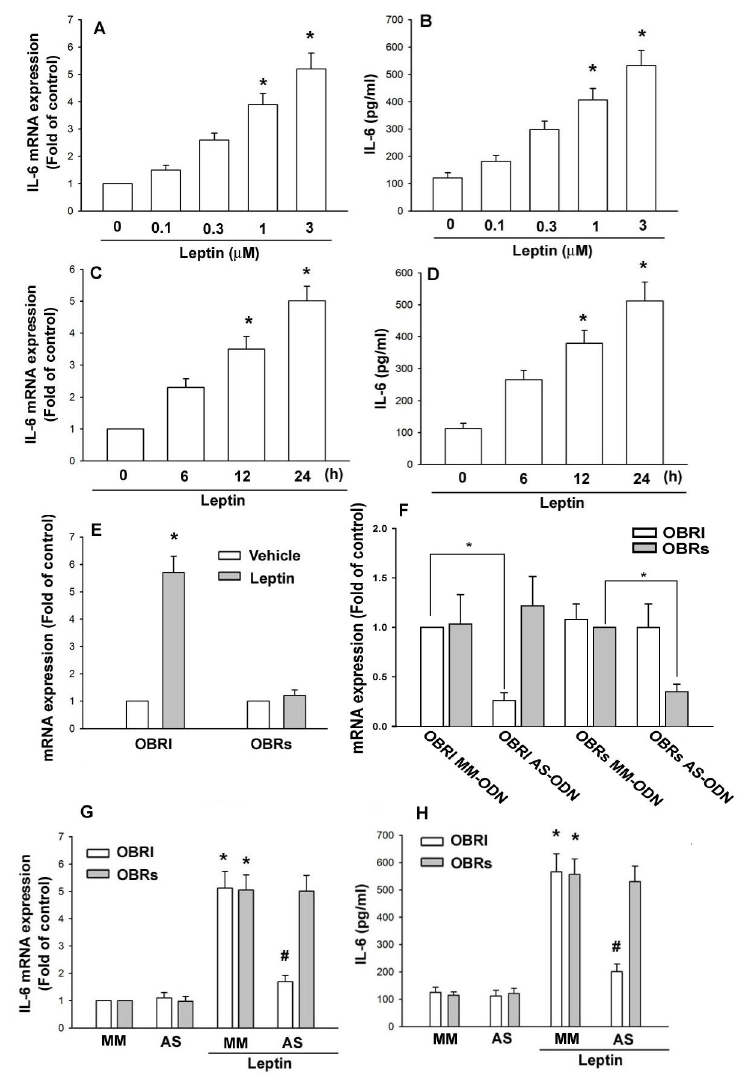
Figure 1. Leptin induces IL-6 expression in human synovial fibroblasts through OBRl receptor. (A and B) OASFs were incubated with various concentrations of leptin for 24 h. Media and total RNA were collected, and the expression of IL-6 was examined by qPCR and ELISA assay (n=4). (C and D) OASFs were incubated with leptin (3 µM) for 6, 12, or 24 h. Media and total RNA were collected, and the expression of IL-6 was examined by qPCR and ELISA assay (n=4). (E) OASFs were incubated with leptin (3 µM) for 24 h. OBRl and OBRs mRNA expression was examined by qPCR (n=4). (F) OASF cells were transfected with OBRl and OBRs AS-ODN or OBRl and OBRs MM-ODN, and mRNA level of OBRl and OBRs was analyzed by qPCR (n=4). (G